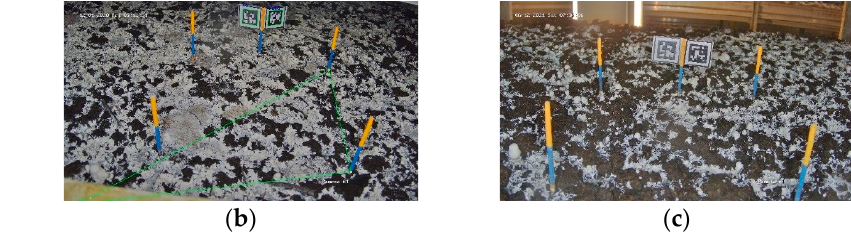
Figure 4. Examples of images collected during image acquisition which cannot be used in the analysis because of bad calibration ( a , b ), external light source ( c ).